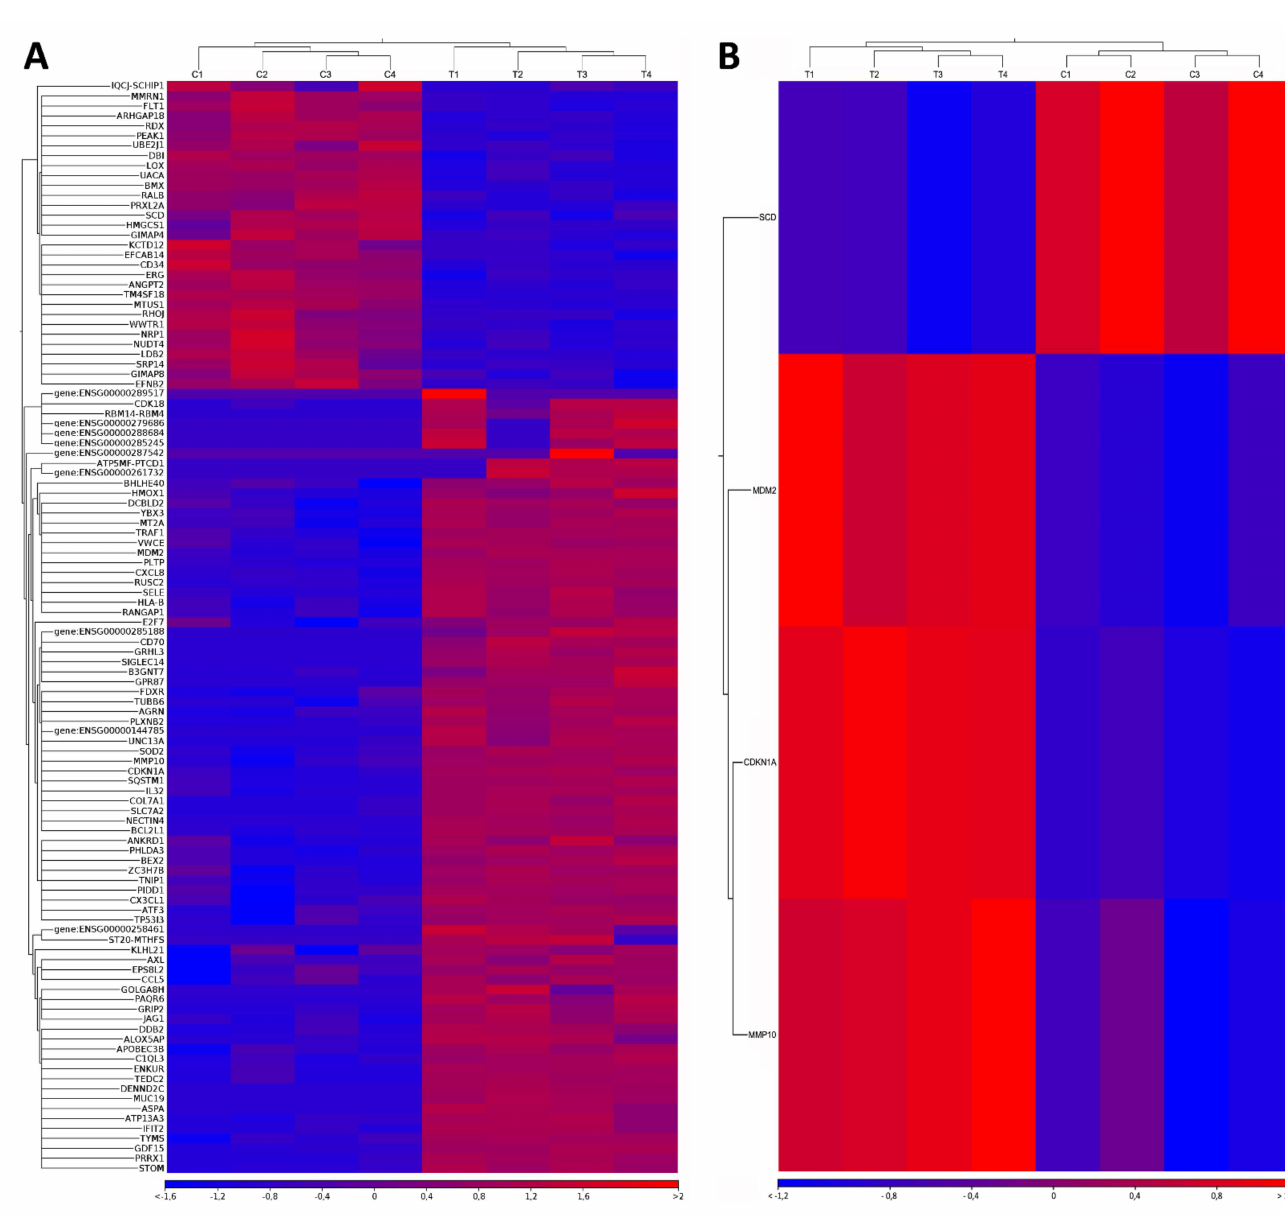
Figure 1. Heatmaps of differentially expressed genes (DEGs) identified in ( A ) Human Coronary Artery Endothelial Cells (HCAEC) and ( B ) Human Internal Thoracic Endothelial Cells (HITAEC) exposed to mitomycin C (MMC) in comparison with the non-exposed control (only those having FDR p -value < 0.05 are presented in the heatmaps). Top panel—the results of hierarchical sample clustering (C1, C2, C3, and C4—the control group, T1, T2, T3, and T4—the treatment group). Left panel—the results of hierarchical DEGs clustering (DEGs labeling based on Ensembl annotation). Bottom panel—the absolute fold